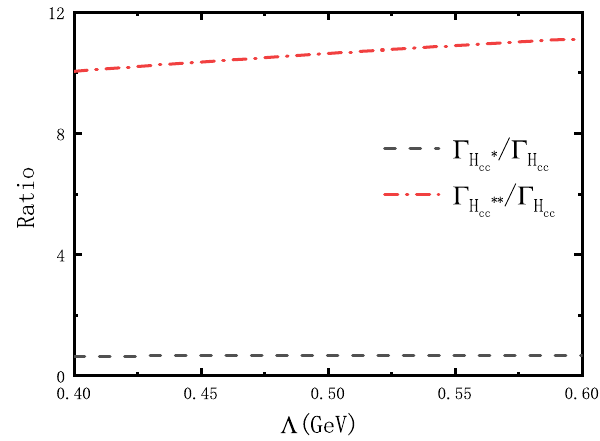
Fig. 5 Ratios between decay widths of H ( ∗∗ ) c → (cid:3) + c (cid:3) + c as functions of the cutoff